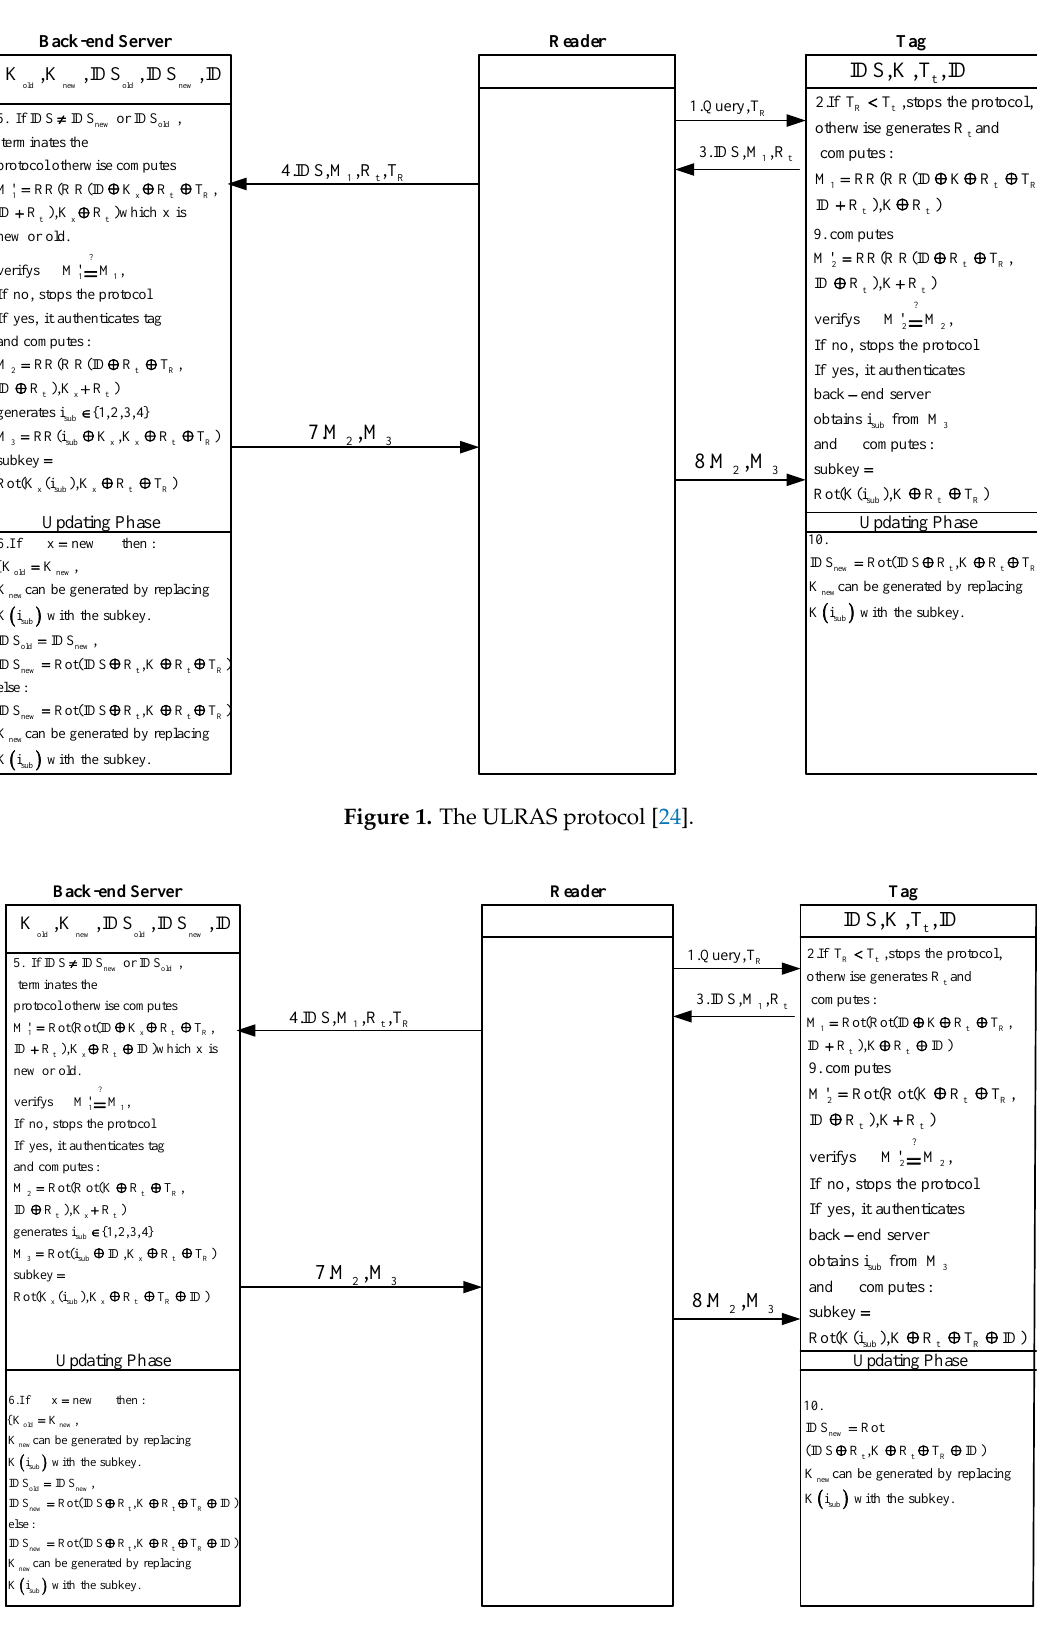
Figure 2. The Aghili and Mala improvement protocol from ULRAS